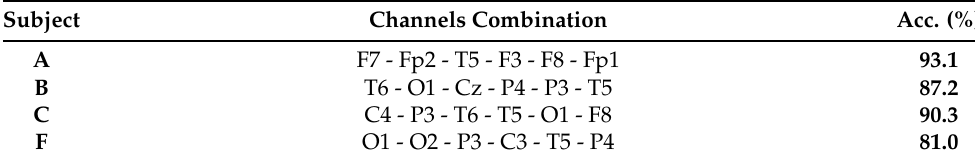
Table 9. Classification accuracies achieved for each 6-channel combination.